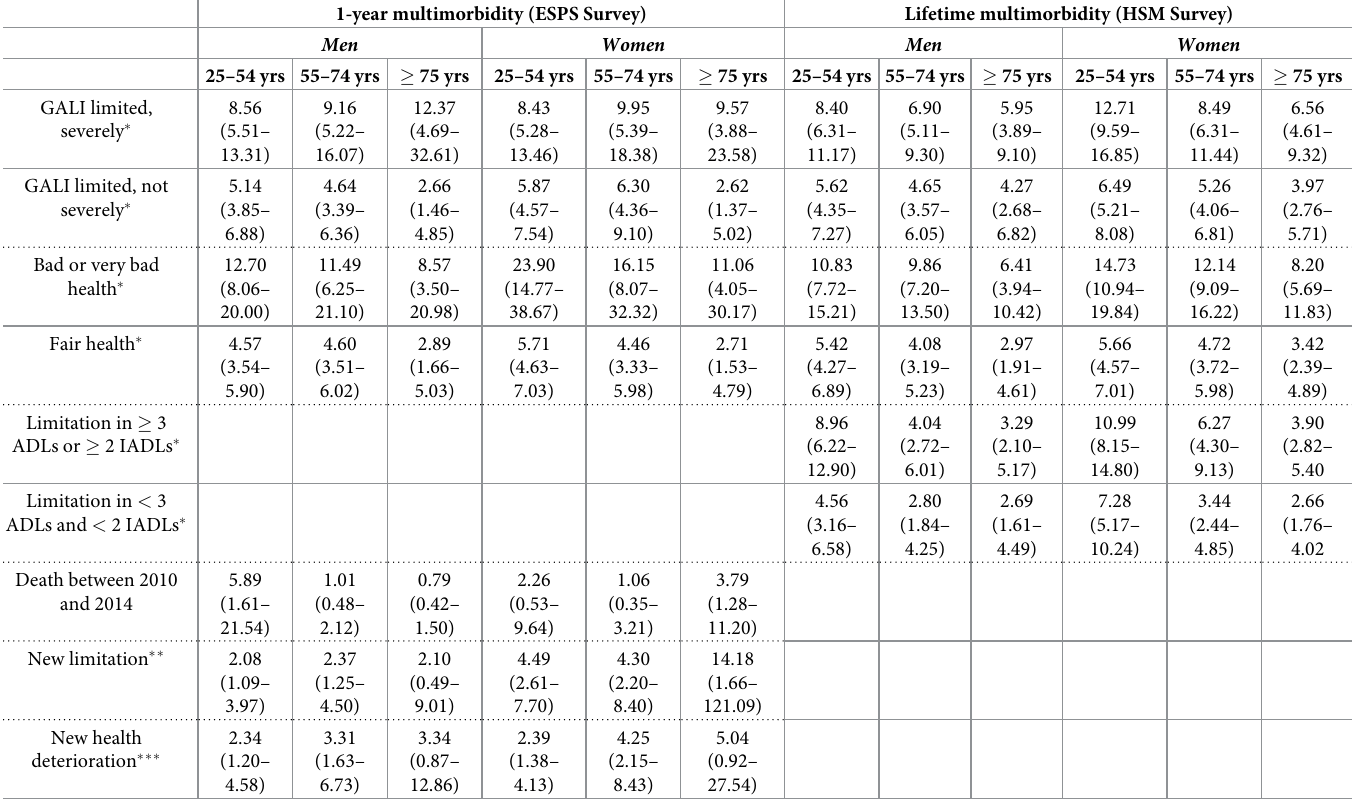
Table 3. Associations of multimorbidity with health outcomes according to age and gender as estimated in multiple logistic regression